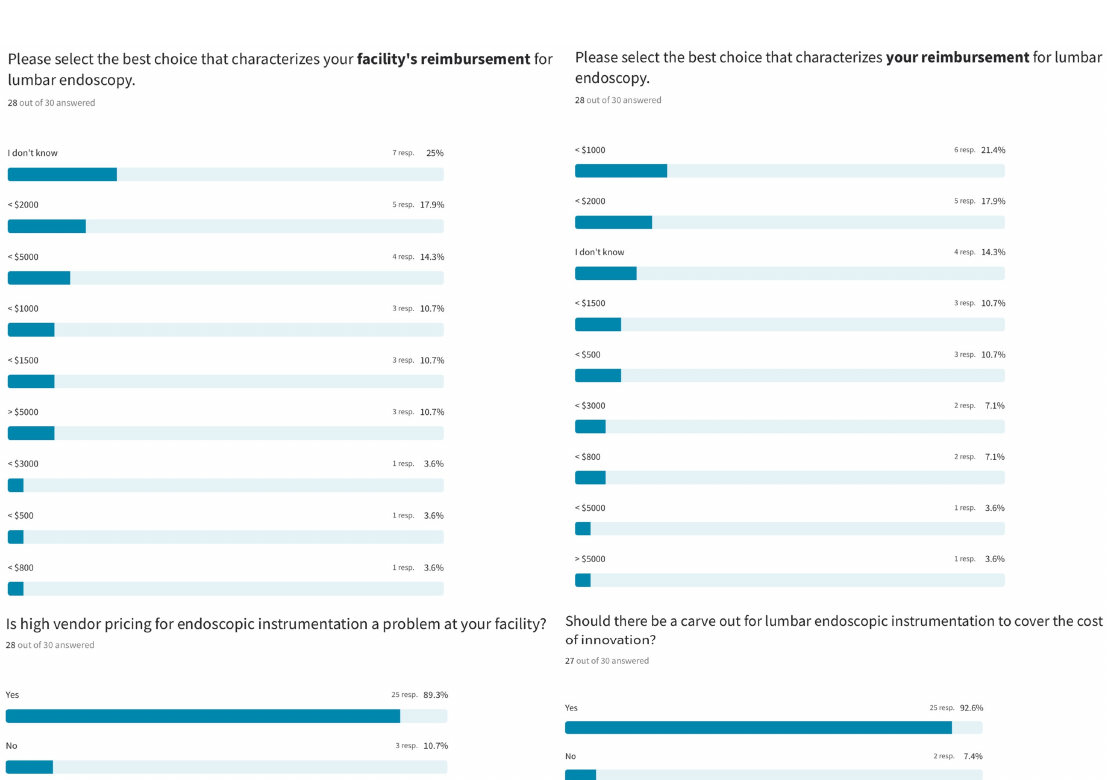
Figure 3. Regarding facility reimbursement for lumbar endoscopic spine surgery, 25% of responding surgeons did not know what their facility was paid. Four surgeons (14.3%) receiving cash payments indicated their facility’s payment was under USD 5000. The majority (46.5%) reported their facility receiving less than USD 2000, while 10.7% reported receiving less than USD 1500 and 17.9% reported receiving less than USD 1000. The professional fee received by surgeons was <USD 1000 for 21.4%, <USD 2000 for 17.9%, and <USD 1500 for 10.7%, meaning the fee was less than USD 2000 for 50% of responding surgeons. Only three surgeons (10%) were paid more than USD 2000 for lumbar endoscopic spine surgery. The majority (89.3%) reported high vendor pricing as problematic at their healthcare facility, making the case (92.6%) for an endoscopic instrumentation carveout to pay for the added cost of the